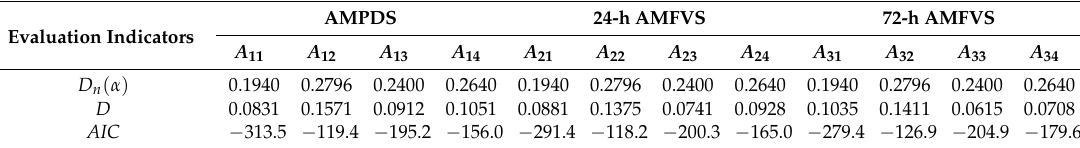
Table 9. Goodness-of-fit test results for all flood series.